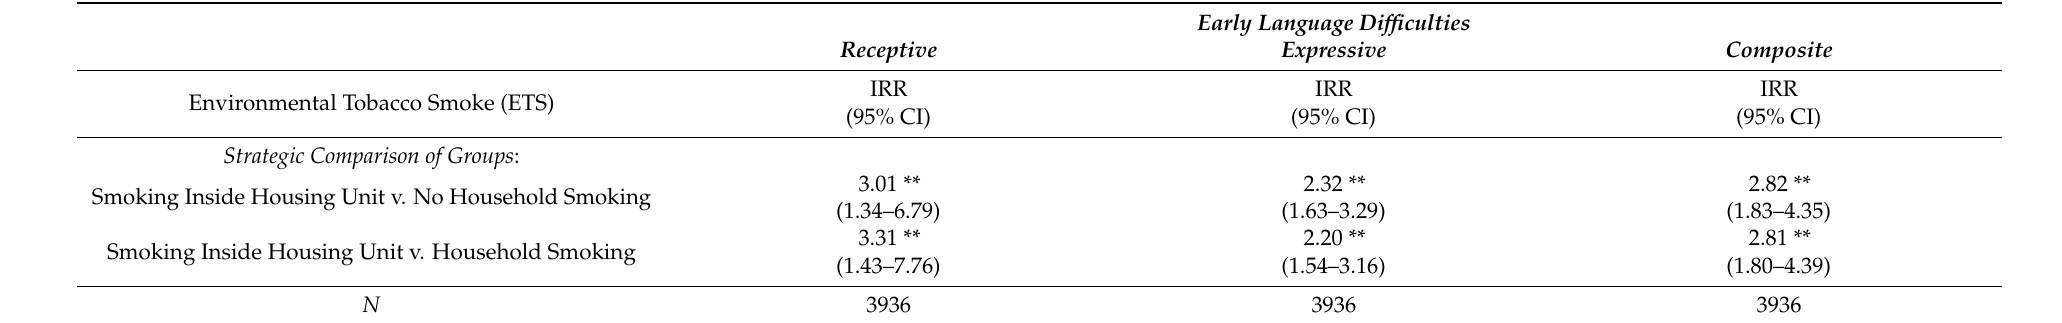
Table 3. Strategic comparison of early language difficulties between ETS categories among the male